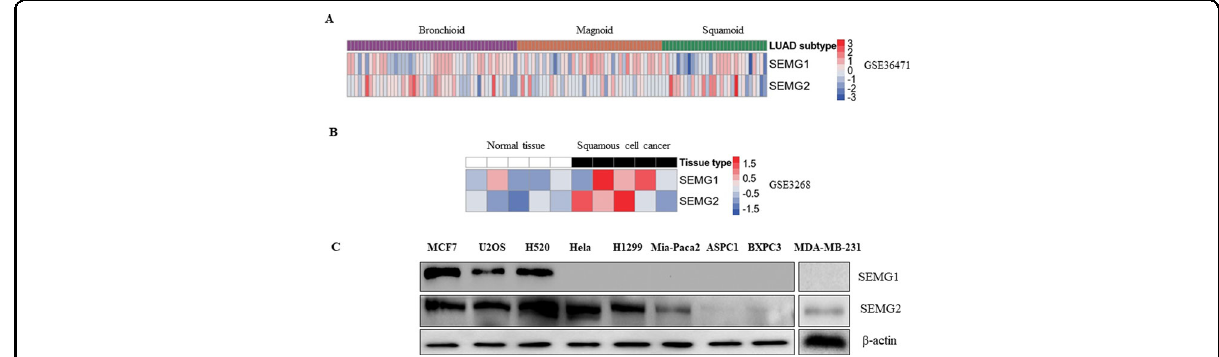
Fig. 1 SEMG1 and SEMG2 are frequently expressed in human cancer cell lines of different origin and clinical samples. A Heat map of SEMG1 and SEMG2 expression in human lung cancer cell models (GSE36471) based on the RNA-seq data. Pre-calculated expression values (Phantasus software) were log-transformed and quantile normalized using the R (v3.61) statistical language in the R studio software (v1.2.5001). Heatmaps were produced using the ggplot2 library. B Heat map of SEMG1 and SEMG2 expression in clinical samples of lung squamous carcinoma (GSE3268) and the corresponding normal tissue. C Western-blot analysis of several human tumor cell lines of different origin for SEMG1 and SEMG2